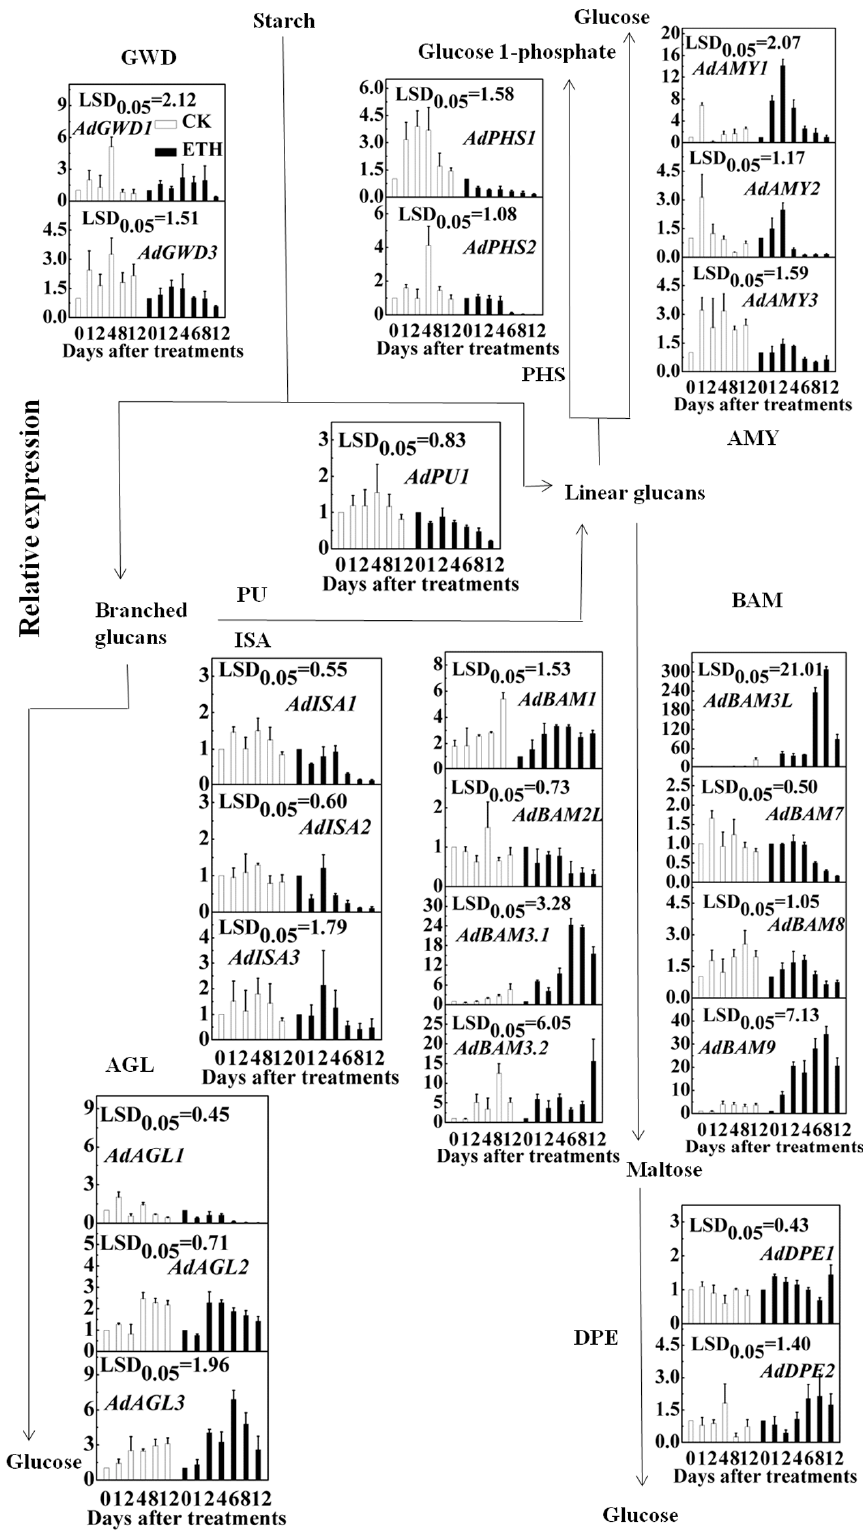
Figure 4. Expression of starch-related genes in response to ethylene treatment (ETH, 100 µL/L, 24 h) at 20 °C. Relative mRNA abundance was evaluated by real-time PCR. White columns, CK; Black columns, ETH. Day 0 fruit values were set as 1. Error bars represent ±SE from three replicates. LSDs represent least significant difference at p = 0.05.